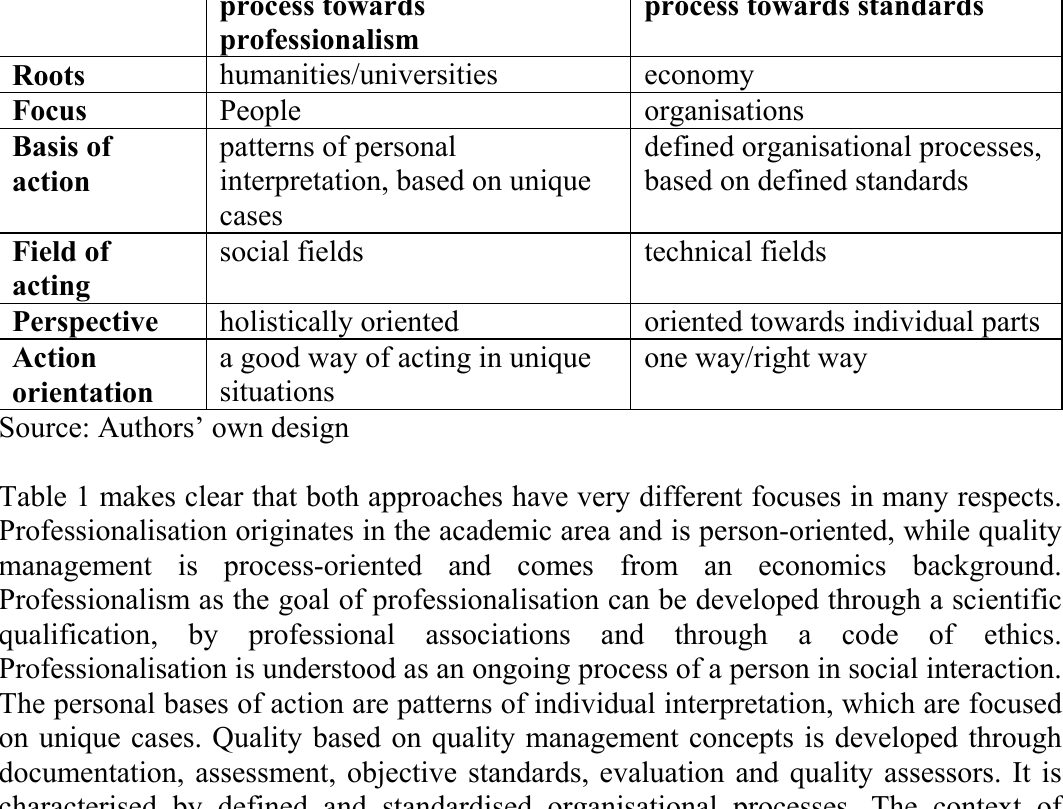
Table 1. Differences between professionalisation and quality management Professionalisation as